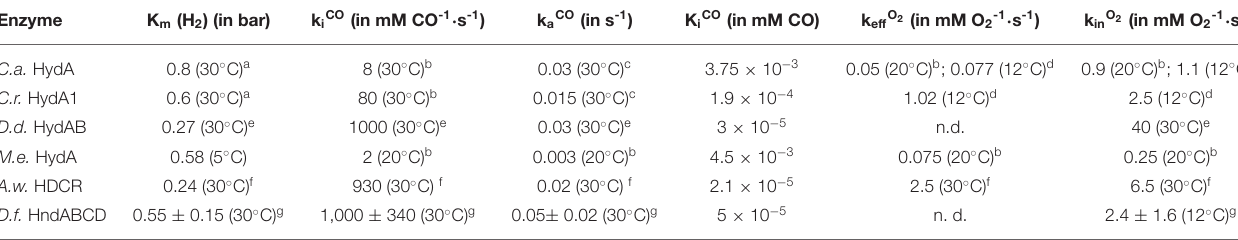
TABLE 3 | Comparison of the kinetic parameters determined by electrochemistry of different FeFe hydrogenases, including Hnd. Enzyme K m (H 2 ) (in bar) k iCO (in mM CO -1 · s -1 ) k aCO (in s -1 ) K iCO (in mM CO) k effO 2 (in mM O 2-1 · s -1 )